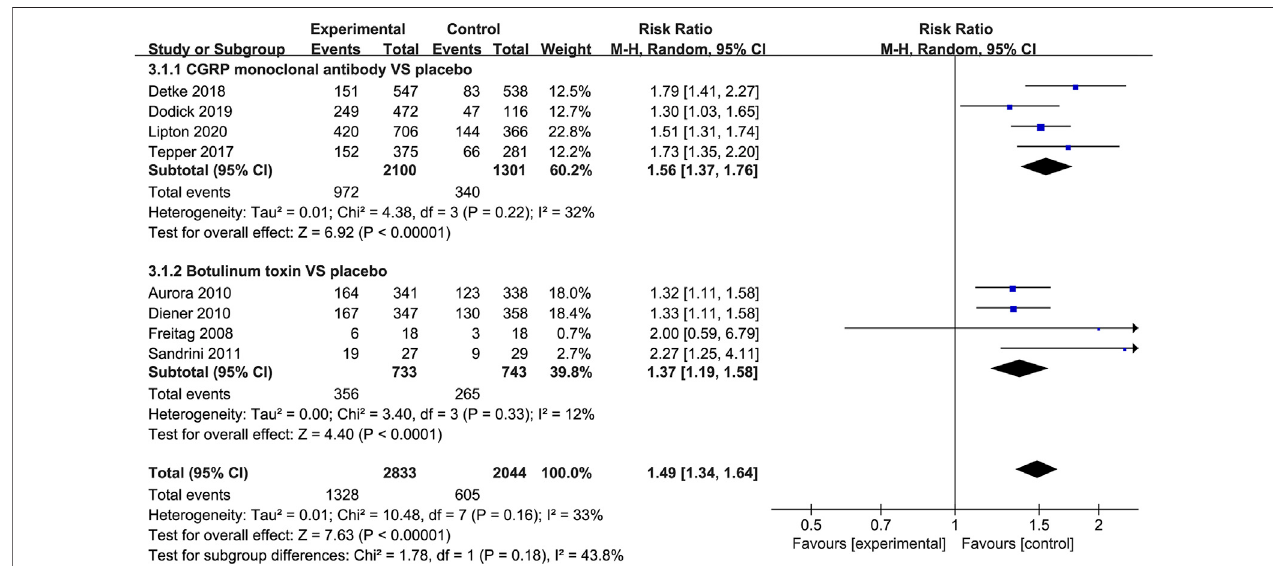
FIGURE 5 | Pooled relative risk of the 50% migraine responder rate compared with placebo; diamond indicates the estimated relative risk with 95% con fi dence interval for the pooled patients.